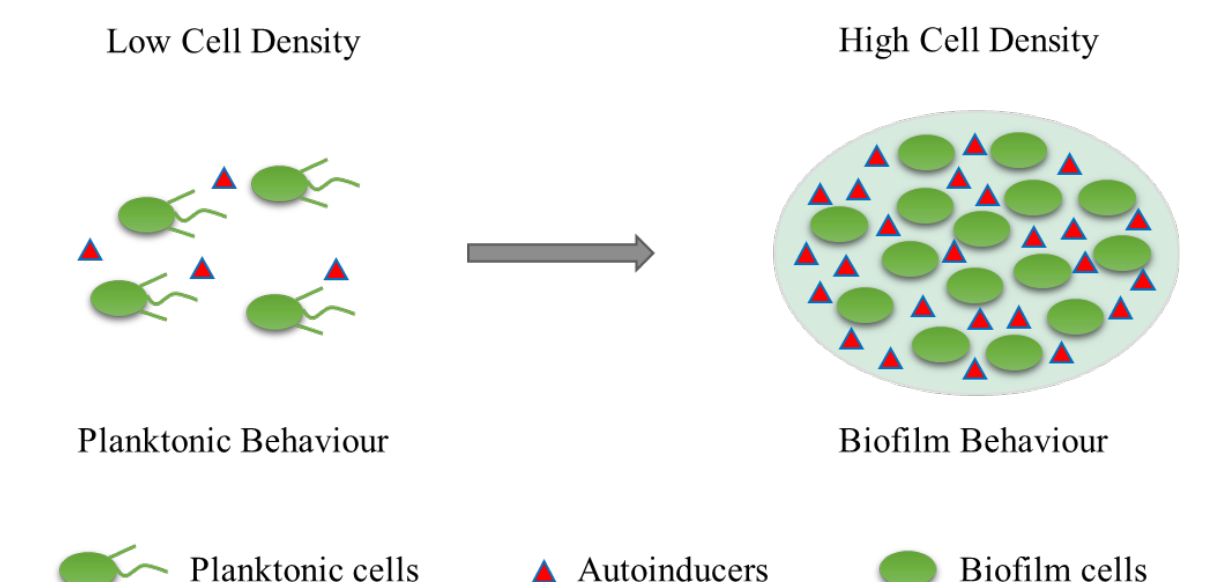
Figure 1. The five main phases leading to the development and formation of biofilm: (1) reversible attachment; (2) irreversible adhesion; (3) early development of biofilm structure (formation of small colonies); (4) biofilm maturation; (5) cell separation and diffusion.